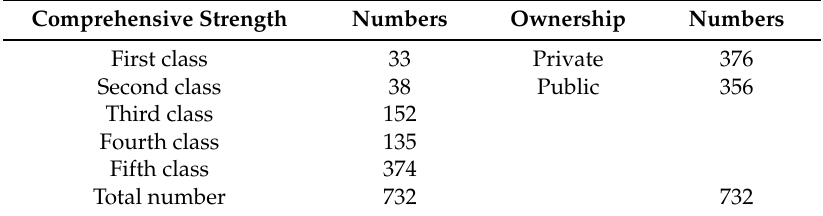
Figure 2. ( a ) Distribution of hospitals and ( b ) pharmacy stores in main urban districts. Table 1. Numbers of hospitals divided by comprehensive strength and ownership in main urban districts.